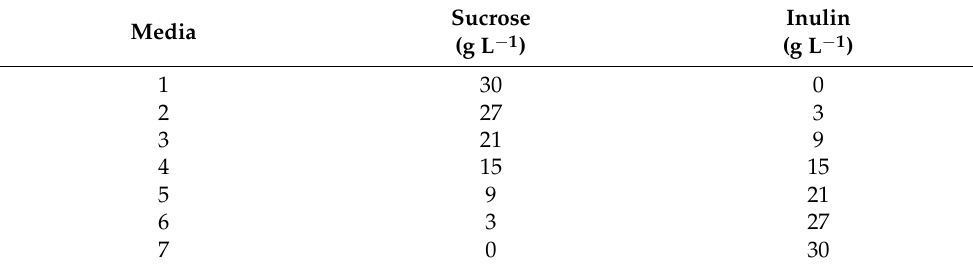
Table 1. Grams of inulin and sucrose in the